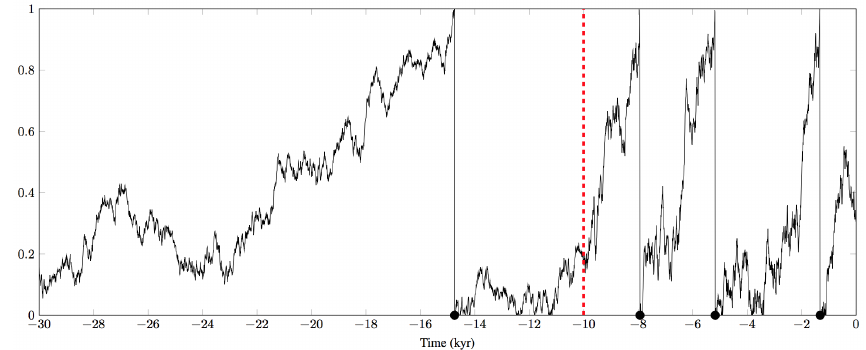
Figure 2. Sample path of stochastic process used for earthquake event time generation. Sample path generated with X 0 = 0 . 16, T min = − 30kyr, t = − 10kyr, ν = ( 15kyr, 3kyr), τ = 0 . 5, and (cid:49)t ≈ 0 . 007kyr. The corresponding earthquake times are represented by dots on the 1 time axis, the switch point t 1 is represented by a red vertical line.